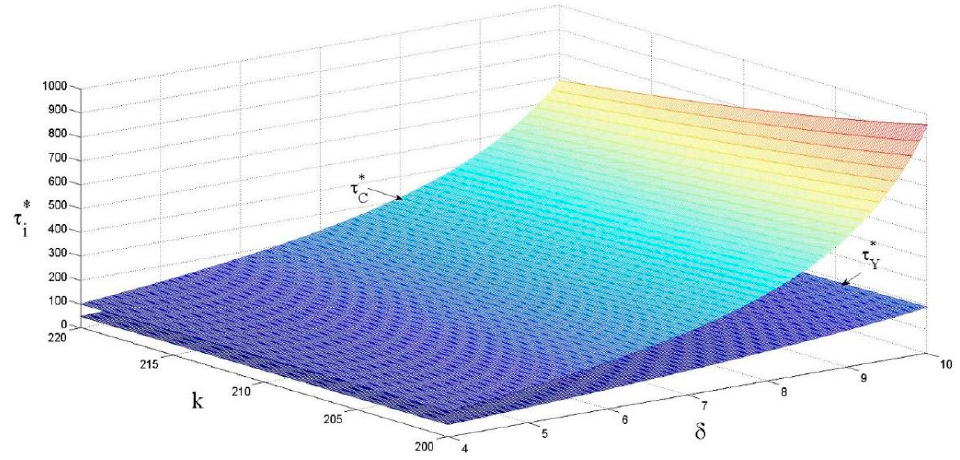
Figure 3. The effects of k and δ on the eco-design effort